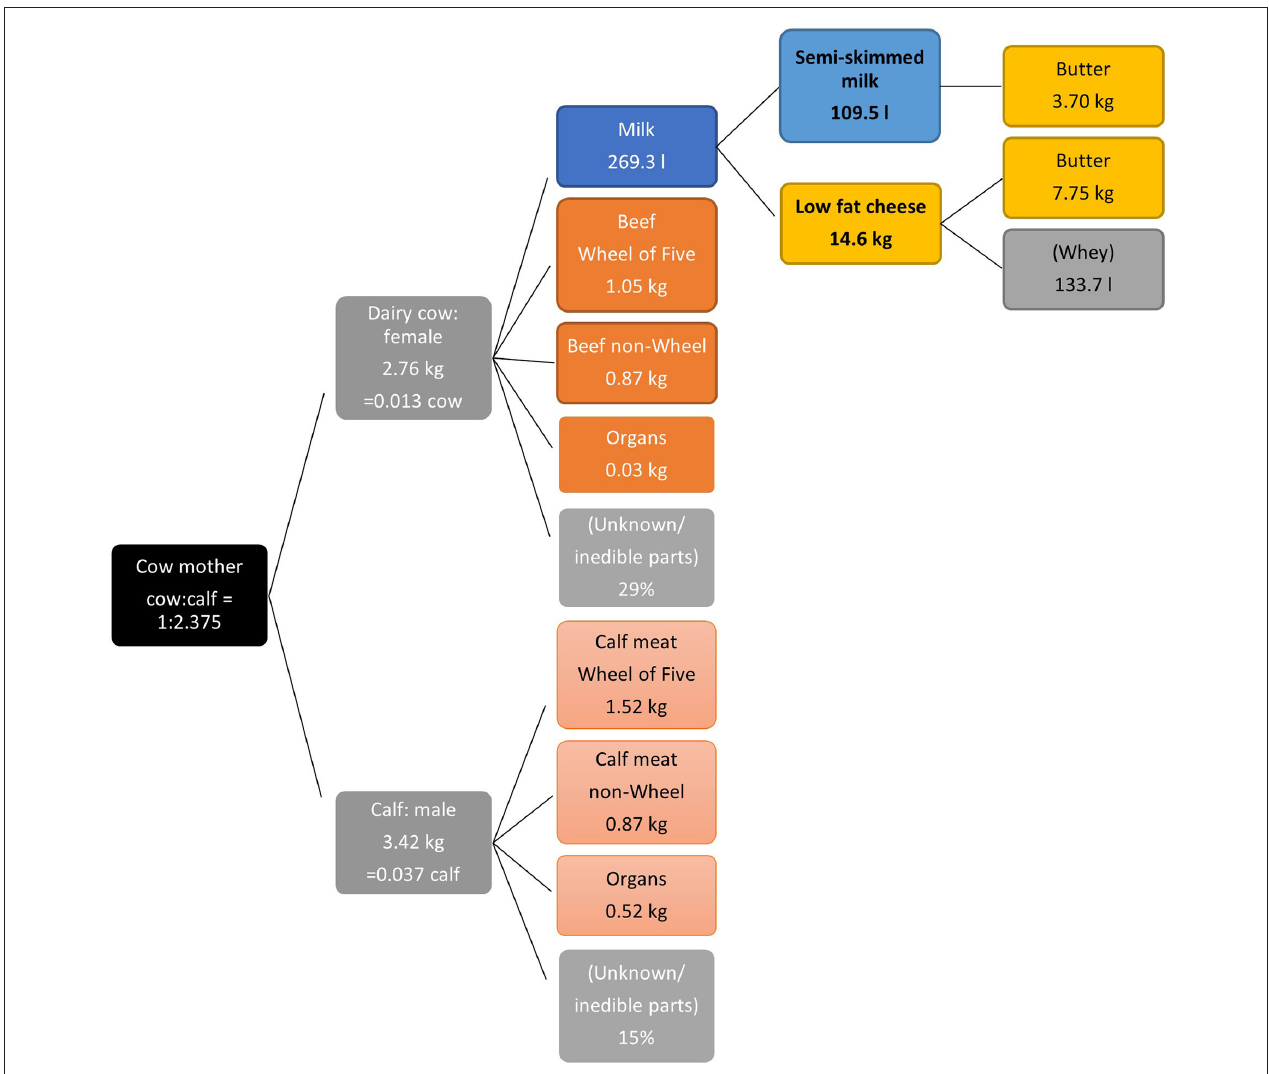
FIGURE 2 | Model with interdependencies in the dairy cow system (products in parenthesis are outside the model), illustrated by the quantities related to the recommended portions of semi-skimmed milk and low-fat cheese per year for adults 19–50 years